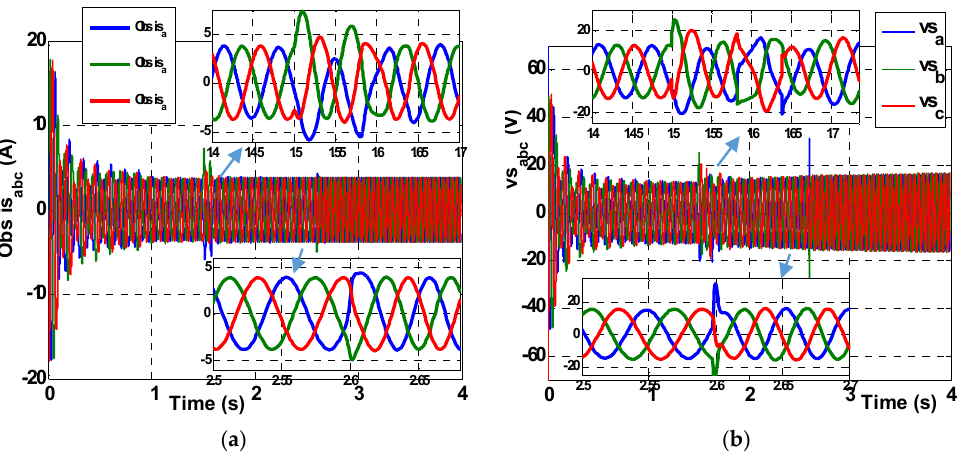
Figure 13. Developed FTC-performance of the wind turbine system driven IG with ITSC fault of 30% of s 1 -phaseat t = 1.5 s under 50% increase in both stator and rotor resistance values at t = 1.5 s and then under a sudden wind speed variation at t = 2.6 s: ( a ) three-phase stator SMO reconstructed currents ˆ i s abc and ( b ) stator voltages v sabc with their zooms.